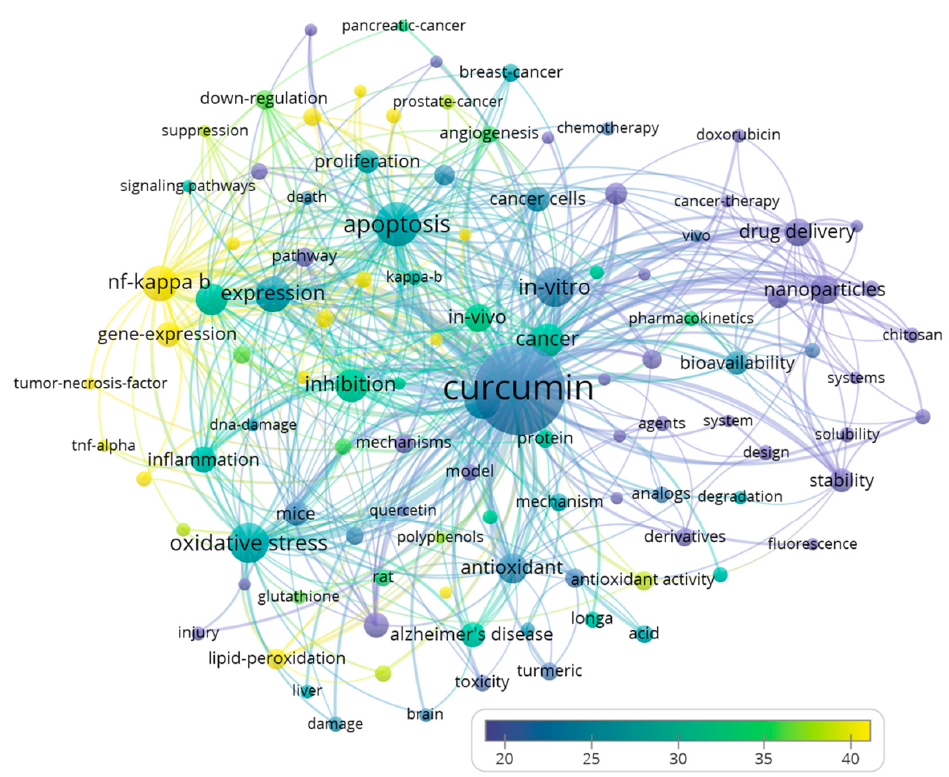
Figure 2. Bubble map visualizing keywords of the 18,036 curcumin publications. We used VOSviewer software to analyze and visualize recurring keywords added to the publications by the authors and by Web of Science. Only keywords that appeared in at least 1.0% ( n = 181) of the publications were analyzed and visualized. There were 108 keywords that appeared in at least 1.0% of the evaluated publications. The word size indicates the appearance frequency of the words (multiple appearances in a single manuscript count as one). Two words are closer to each other if they co-occurred more frequently in the evaluated publications. Bubble colors represent the averaged citations of the terms. Table 3. The top 20 recurring keywords.